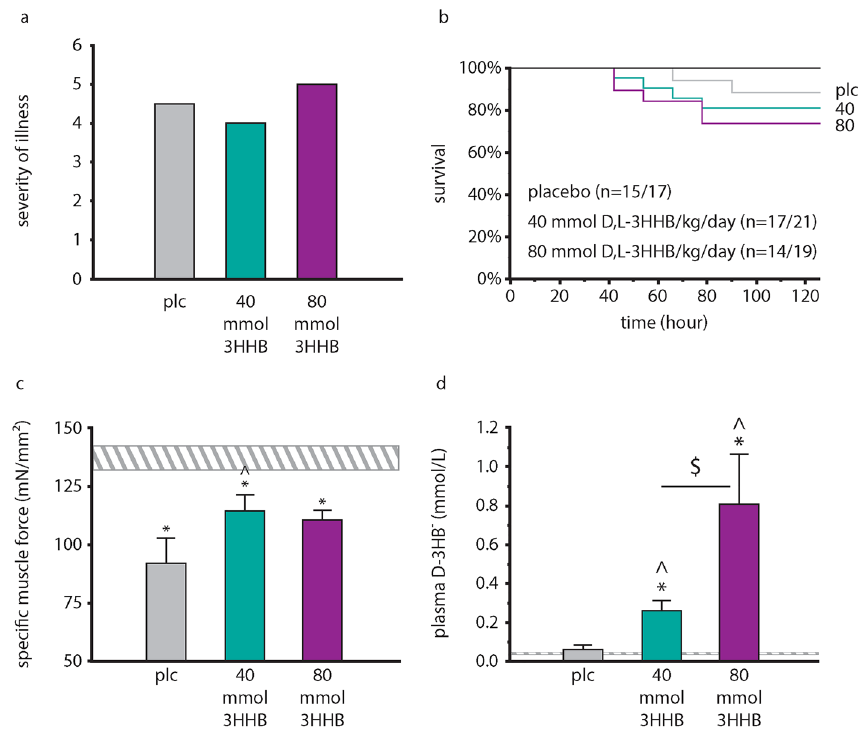
Figure 6. Impact of continuous infusion of d,l-3HHB on severity of illness and mortality, muscle force and circulating ketone level. ( a ) Cumulative severity of illness. Data are shown as medians. Number of animals equals total number of animals reported in panel ( b ). ( b ) Cumulative survival of the study. Number of animals is reported as n = survivors/total. 40: 40 mmol/kg/day d,l-3HHB; 80: 80 mmol/kg/day d,l-3HHB. ( c ) Ex vivo EDL force measurements presented as peak tetanic tension per unit muscle mass. ( d ) Plasma d-3HB − levels assessed at sacrifice. ( c , d ) Data are shown as mean ± standard error of the mean. White–grey shaded horizontal bar, healthy control (n = 15); vertical bars: plc (n = 15); d,l-3HHB: 40 mmol/kg/day (n = 17); 80 mmol/kg/day (n = 14). Ctr healthy control, plc placebo, 3HHB 3-hydroxybutyl-3-hydroxybutanoate ester. *p ≤ 0.05 vs healthy control; ^ p ≤ 0.05 vs placebo; $ p ≤ 0.05 between